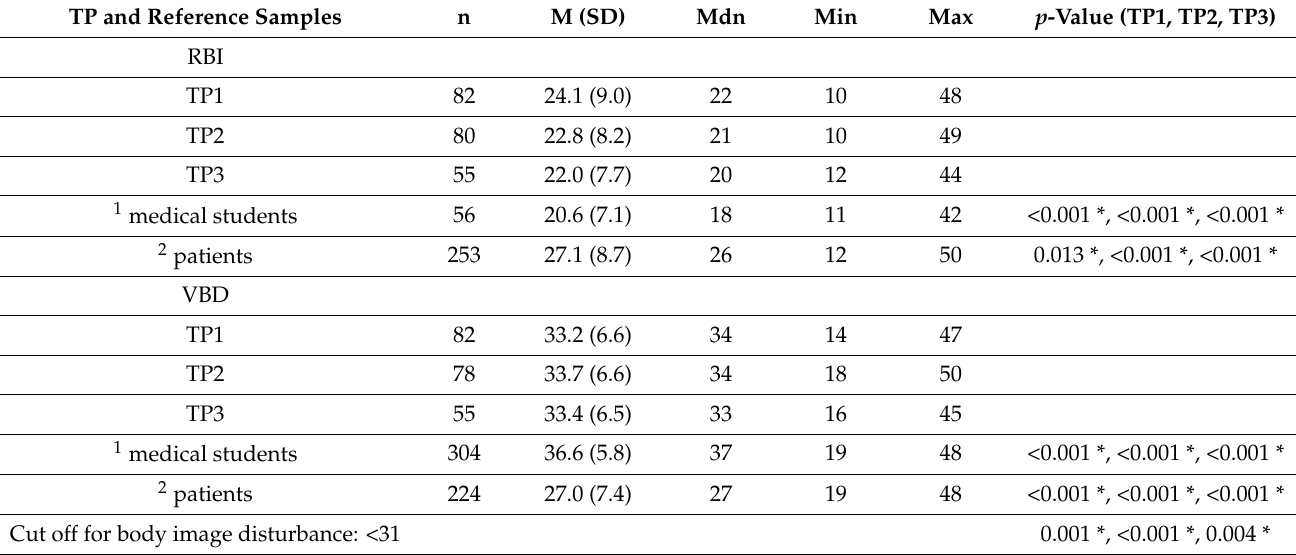
Table 8. Descriptive evaluation and Wilcoxon signed-rank test of the RBI scale (FKB-20) compared to two reference sample groups and descriptive analysis of the VBD (FKB-20) including the two reference samples and Student- t test including the Cut-off